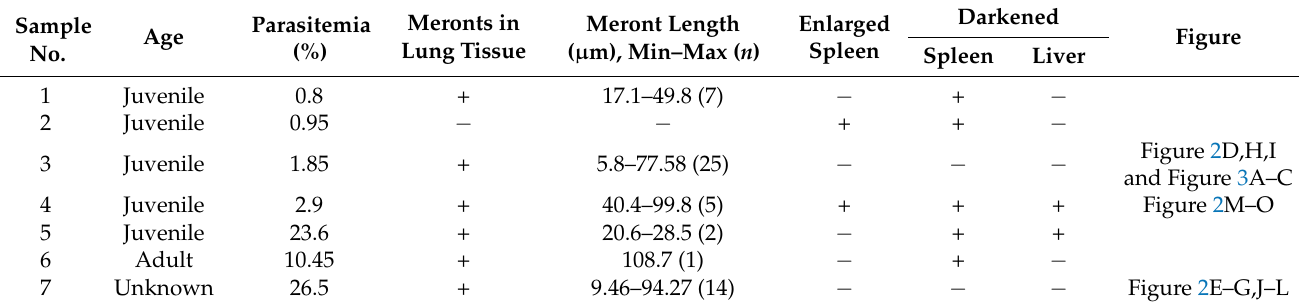
Figure 1. Bayesian phylogeny based on cytochrome b gene fragments (479 bp) of 36 lineages of avian haemosporidian parasites, including 30 lineages of Haemoproteus , 5 of Plasmodium and one of Leucocytozoon, which was used as outgroup. Parasite lineages were shown, followed by species names and DNA sequence GenBank accession numbers. A gray box indicates the clade containing Haemoproteus attenuatus (hROBIN1). Vertical bars show species of subgenera Parahaemoproteus ( A ) and Haemoproteus ( B ) as well as lineages of Haemoproteus balmorali ( Aa ) and Haemoproteus majoris ( Ab ) groups (see Discussion for explanation). Haemoproteus species, for which exo-erythrocytic development was formerly reported, were shown in bold font. Species investigated in this study are given in bold font and a red color. Numbers on the nodes represent posterior probabilities. Scale bar indicates the number of expected substitutions per site. Table 1. Age, parasitemia and histological observations of seven European robins Erithacus rubecula infected with Haemopro- teus attenuatus (cytochrome b lineage